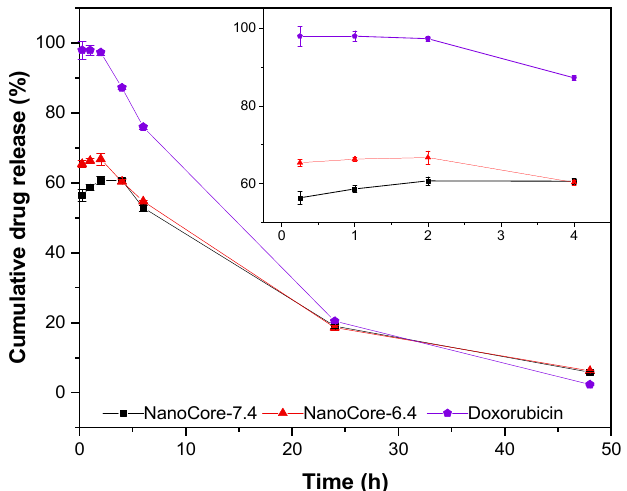
Figure 3. Comparison of in vitro release kinetics of doxorubicin in blood plasma over 48 h and 4 h (in- set) from NanoCore-7.4 (grey), NanoCore-6.4 (red) as well as free doxorubicin (blue) as control ( n = 3, mean ± standard deviation). The release profile is strongly affected by the degradation of doxorubicin in the blood plasma leading to a rapid decrease in the concentration of released doxorubicin.